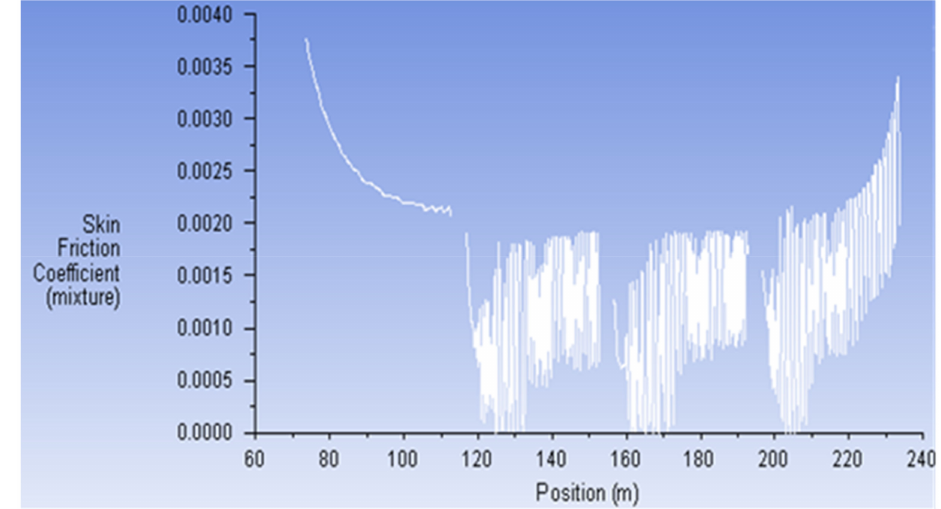
Figure 6. Skin friction coe ffi cient on the air lubricated